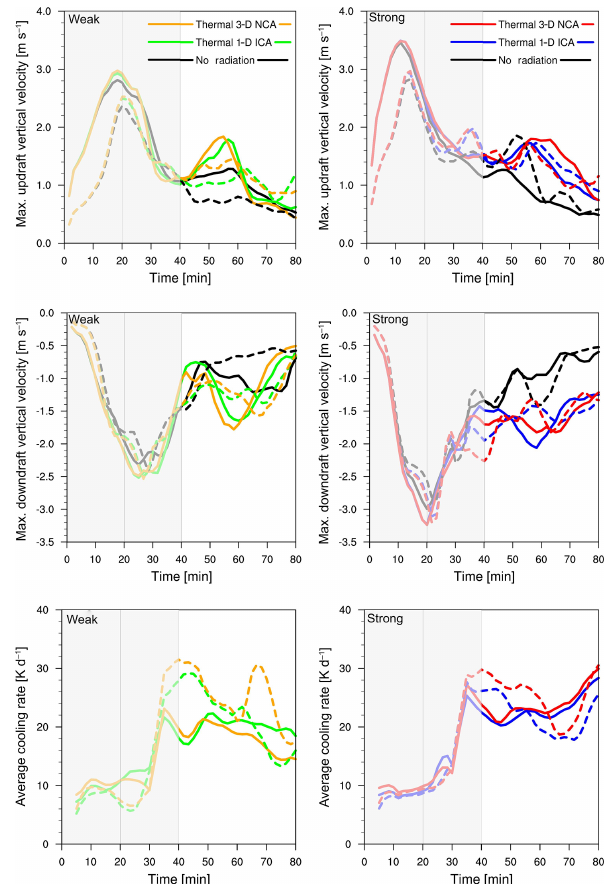
Figure 4. Time development of maximum updraft and downdraft vertical velocity, as well as conditionally sampled cooling rates of the single cloud simulations for the simulations of the single clouds. Cooling rates were sample at the single cloud only. The left col- umn shows the weaker forced single clouds; the right column shows the stronger forced single clouds. Solid lines represent the non- symmetric cloud; dashed lines represent the symmetric